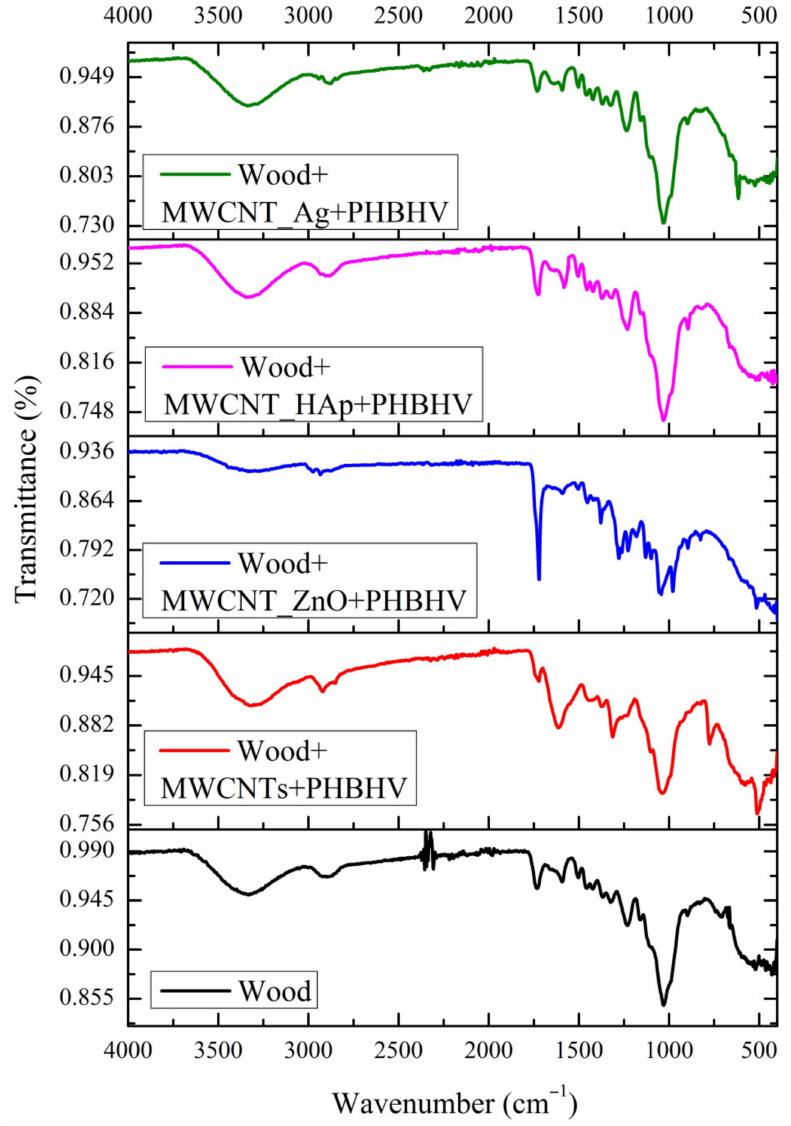
Figure 2. FTIR spectra for untreated and treated